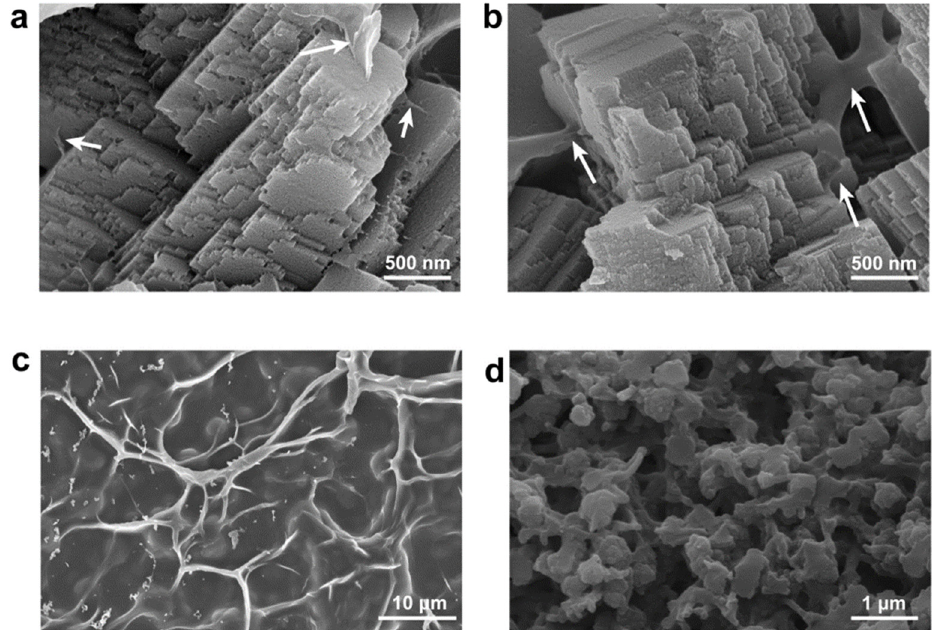
Figure 2. ( a , b ) Cross-sectional SEM images showing the DOX-CaCO 3 -alginate ( a ) and CaCO 3 -alginate ( b ) films obtained in 2 wt% alginate hydrogel matrices, where the white arrows point to the gel networks embedded in the lyophilized samples. ( c ) Top-view SEM image showing the appearance of nanofibrillar networks on the exterior surface of the DOX-CaCO 3 -alginate overlayers after slight etching with water. ( d ) SEM image showing DOX powders precipitated in bulk phase.